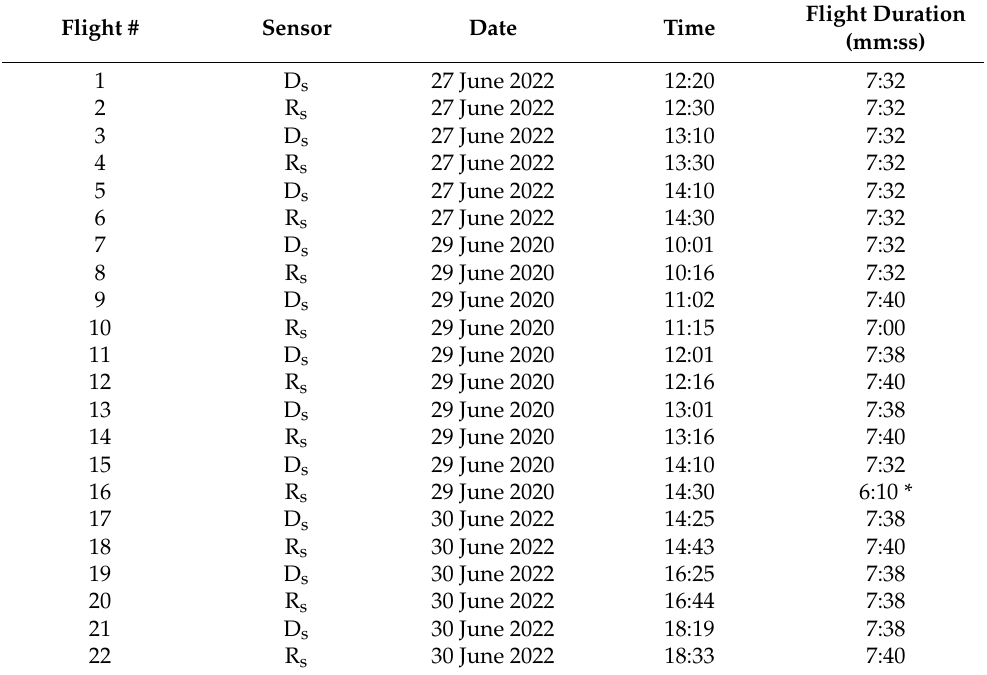
Figure 4. The flight path for each of the n = 22 flights is shown by the red polyline, and the approximate location of each image collection point is denoted with the yellow dots. Note: these locations can display slight variability under differing wind conditions. Table 1. The characteristics of each flight conducted within this study, where D s is the default sensor surface absorptivity as per the manufacturer, R s is the modified shielded sensor, and # is the flight number. * For flight 16, the flight was completed quicker than other flights due to a decrease in head wind